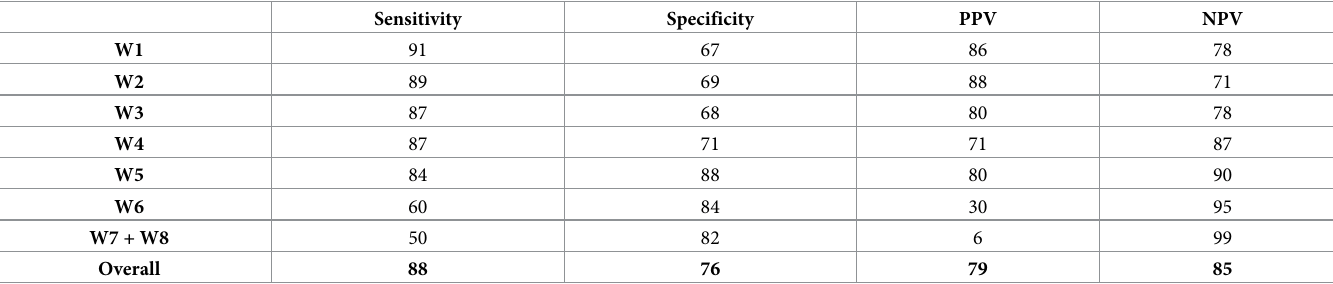
Table 3. Diagnostic performance of chest CT as a function of weeks elapsed since the beginning of the country-wide confinement. Sensitivity Specificity PPV NPV W1 91 67 86